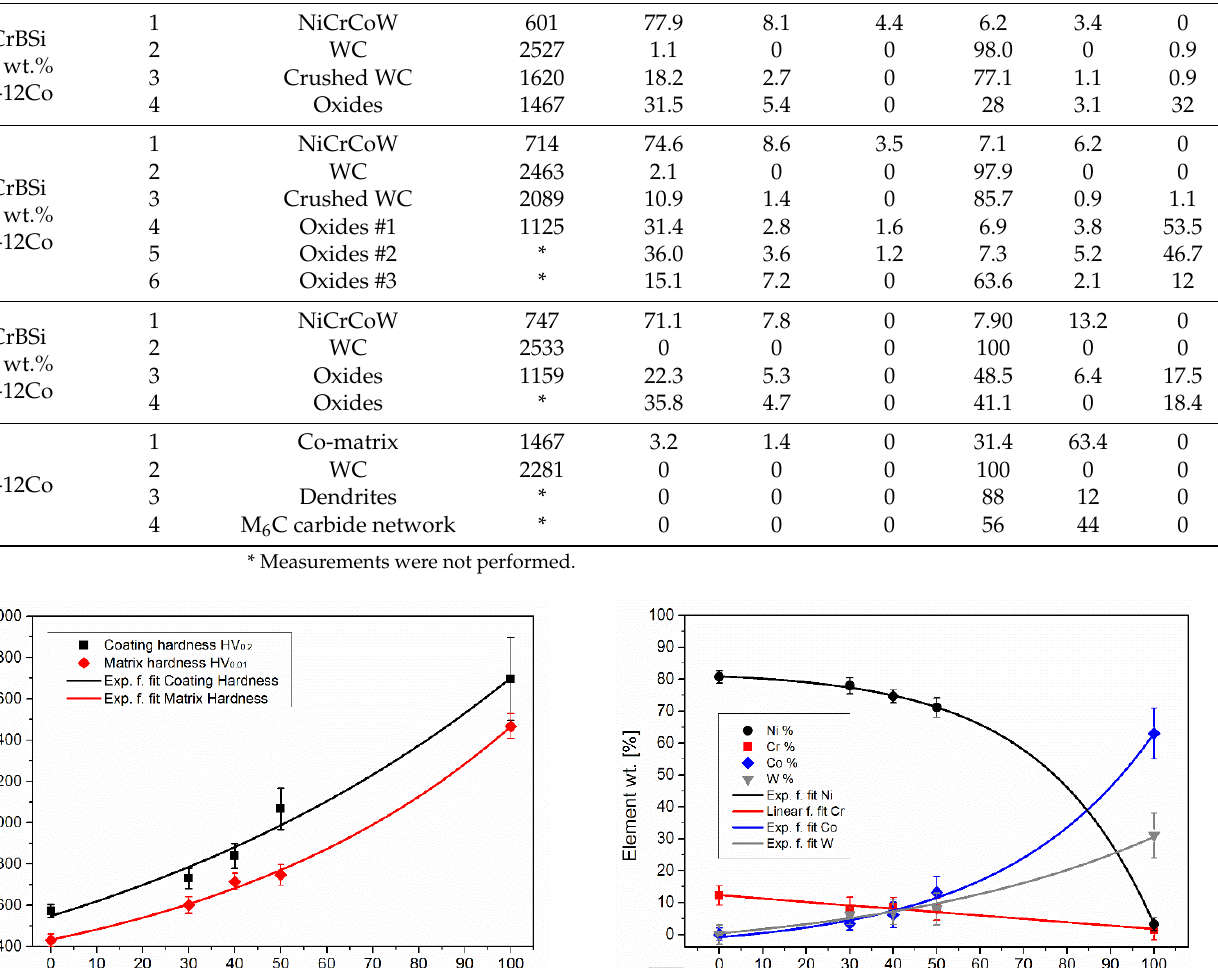
Figure 7. X-ray diffractograms for the ( a ) powders and ( b ) laser cladded coatings.